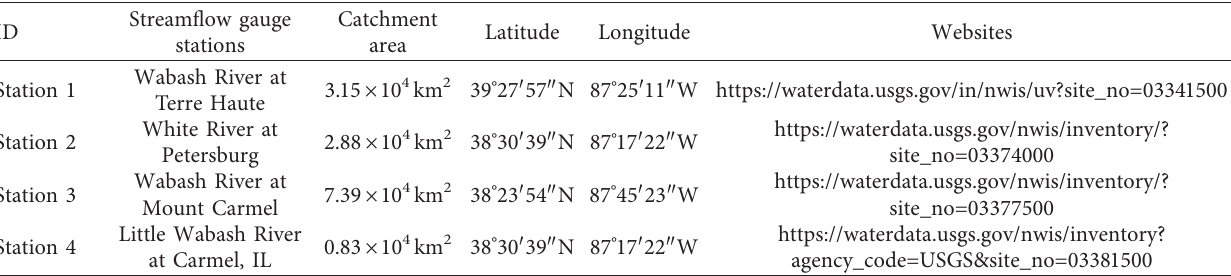
Figure 1: Shaded-relief map of the Wabash River Watershed showing the stream channels delineated with ArcSWATand the locations of the climate data nodes and selected U.S. Geological Survey (USGS) gauge stations. The numbering and exact locations of USGS gauge stations are shown in Table 1. Table 1: Four USGS streamflow gauge stations located in the midstream and downstream of the main stream and major tributaries.